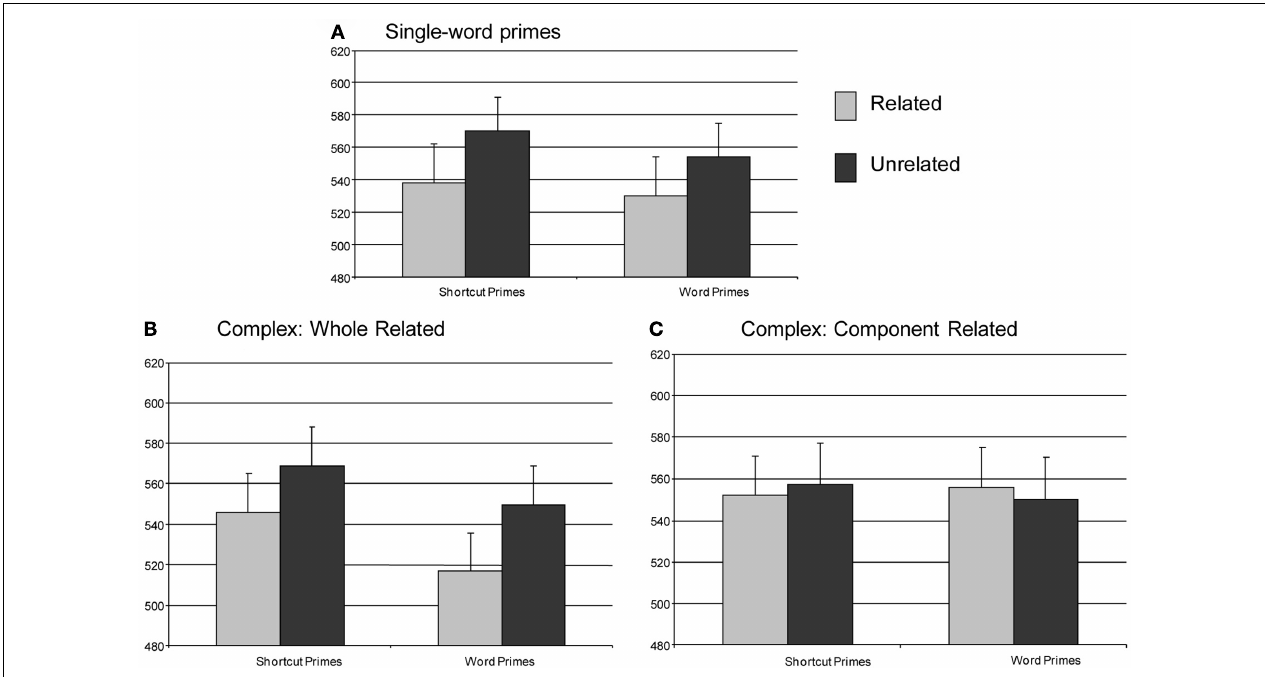
FIGURE 1 | Results of Experiment 1: mean reaction times (ms) as a function of Relatedness and PrimeType for single-word primes (A), whole-related complex primes (B) and component-related complex primes (C). Error bars show the SE.